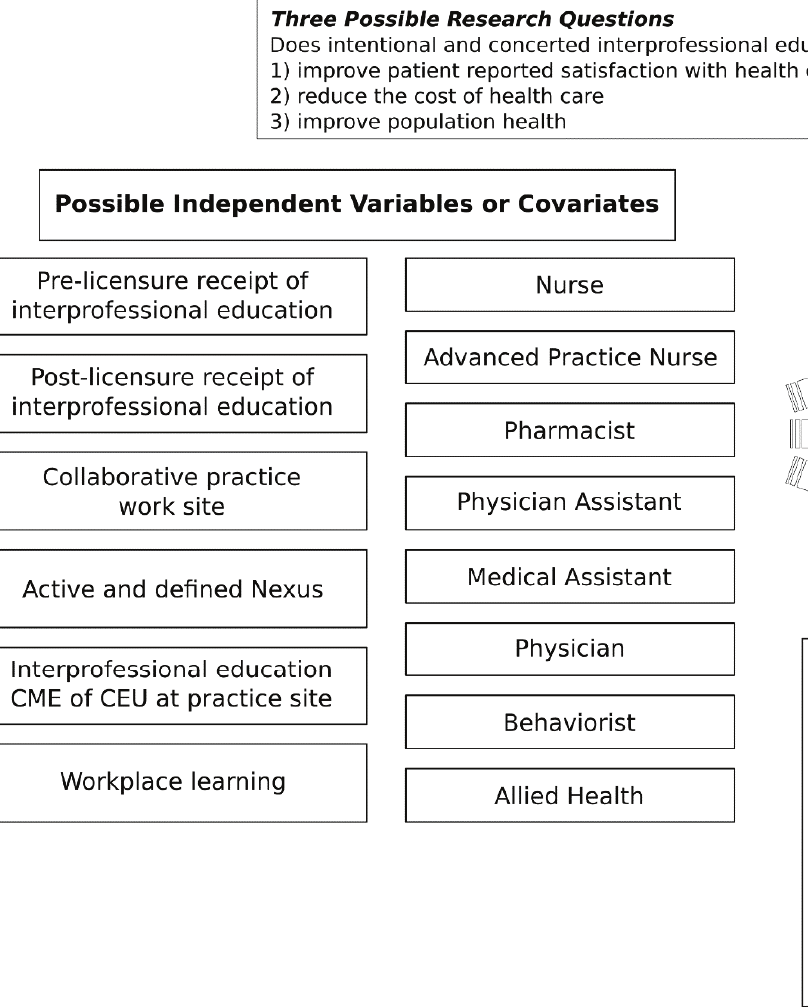
Figure 3. Example of logistic regression analysis models for examining impact of IPECP on triple aim